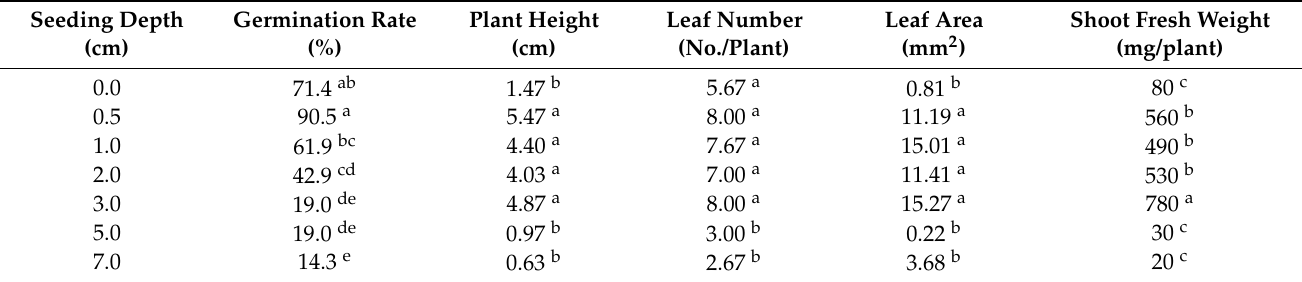
Table 2. Germination rate and growth of A. patulus 10 days after seeding, grown from seeds planted at different depths in field conditions.